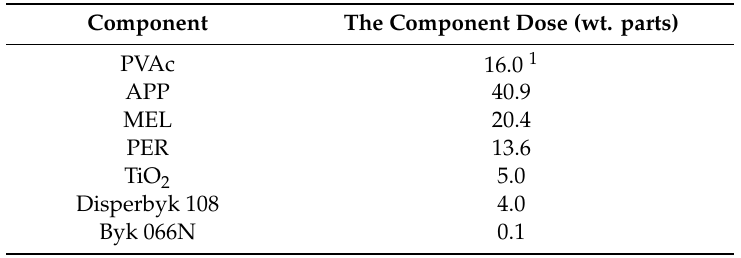
Table 1. The reference intumescent system